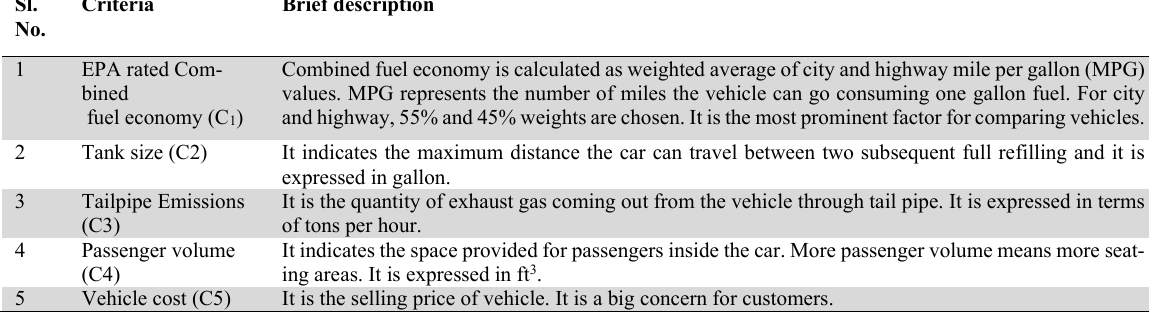
Description of the